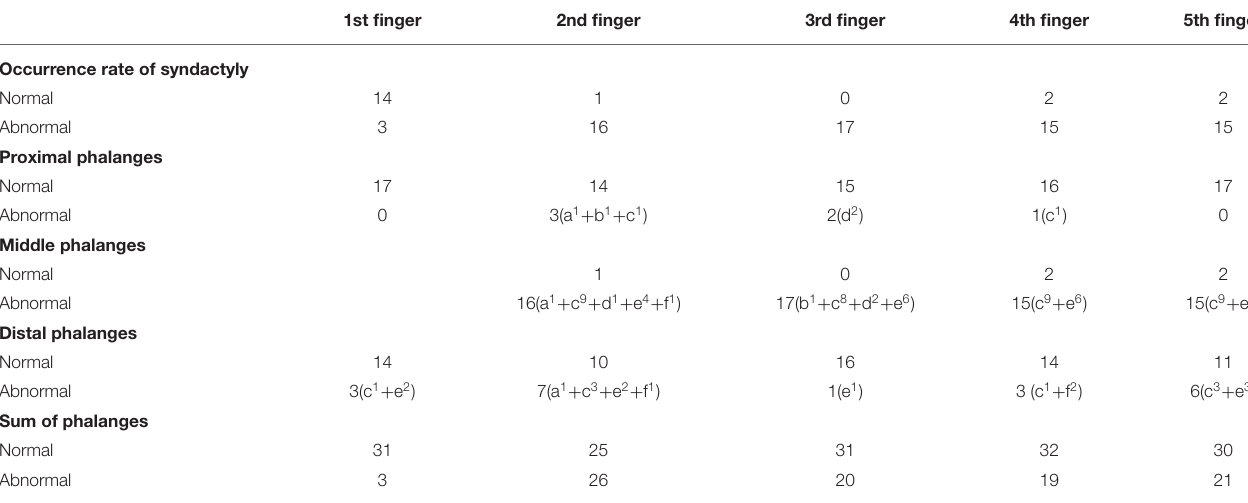
TABLE 1 | Developmental features of affected hands in patients with complicated CSM based on radiographs ( n = 17). 1st finger 2nd finger 3rd finger 4th